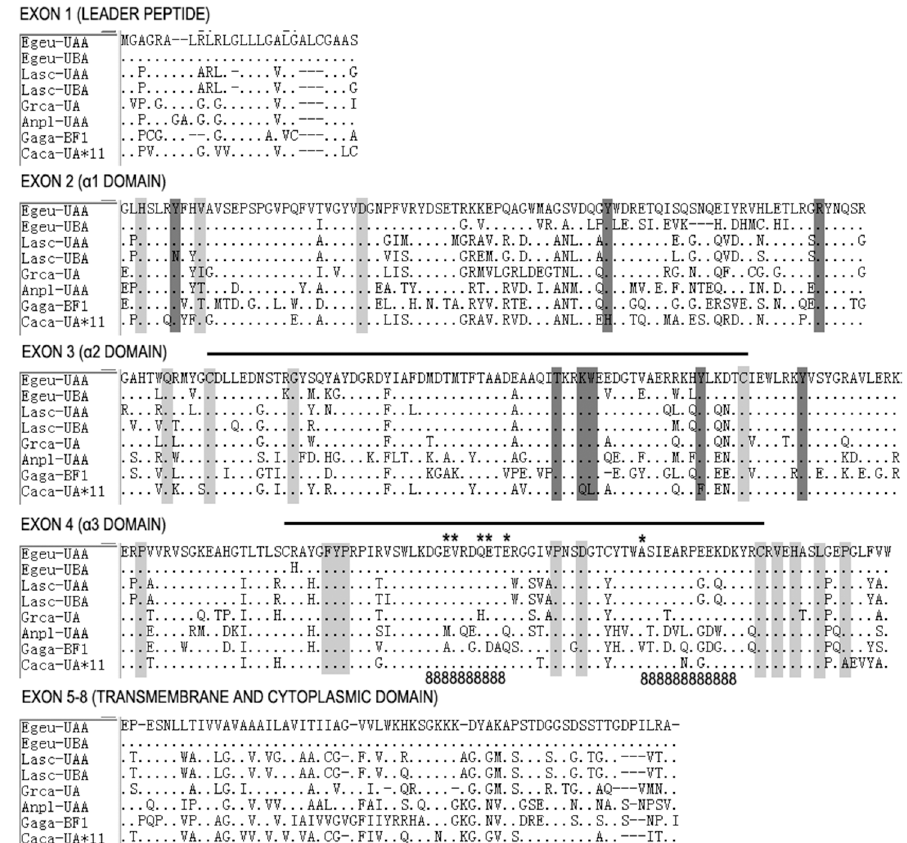
Fig 2. Comparison of amino acid alignment of transcribed MHC class I alpha chain sequences in the Chinese egret with those in other bird species. Dots indicate identity with Egeu-UAA, dashes indicate gaps. Conservedsequencefeatures with predicted functionalor structural roles are shown as: peptidemain chain bindingresidues ( dark grey shading ),intra- and inter-domaincontacts ( light grey shading ),intra-domain disulfidebridges ( horizontallines ), CD8 bindingsites ( “8”s ), critical CD8 co-receptor sites ( * ) [33, 34, 39, 40]. Sequence sources are: Grca (Florida sandhillcrane, Grus canadensis pratensis ,AF033106);Gaga (chicken, G . gallus BF2, AL023516); Anpl (mallardduck, Anus platyrhynchos UAA, AY885227); Lasc-UAA (red-billed gulls, Larus scopulinus UAA, HM015819); Lasc-UBA (red-billedgulls, Larus scopulinus UBA, HM015820); Caca (Red Knot, Calidriscanutus ,